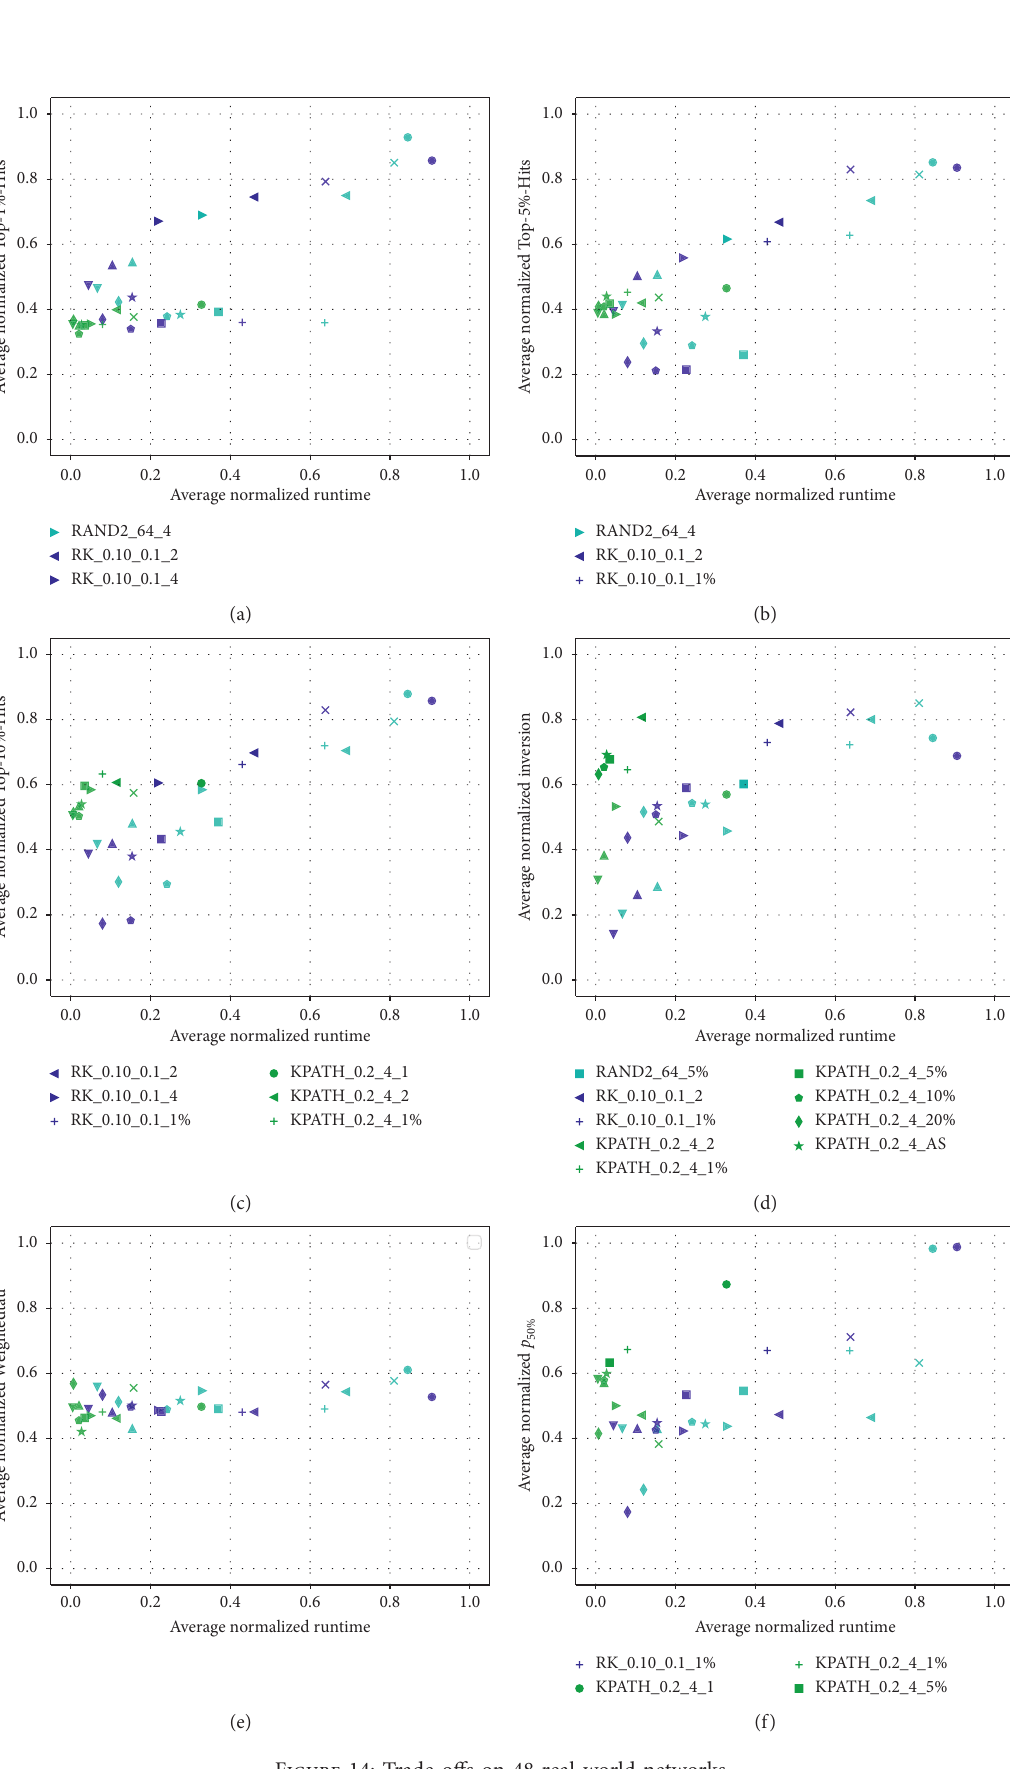
Figure 14: Trade-offs on 48 real-world